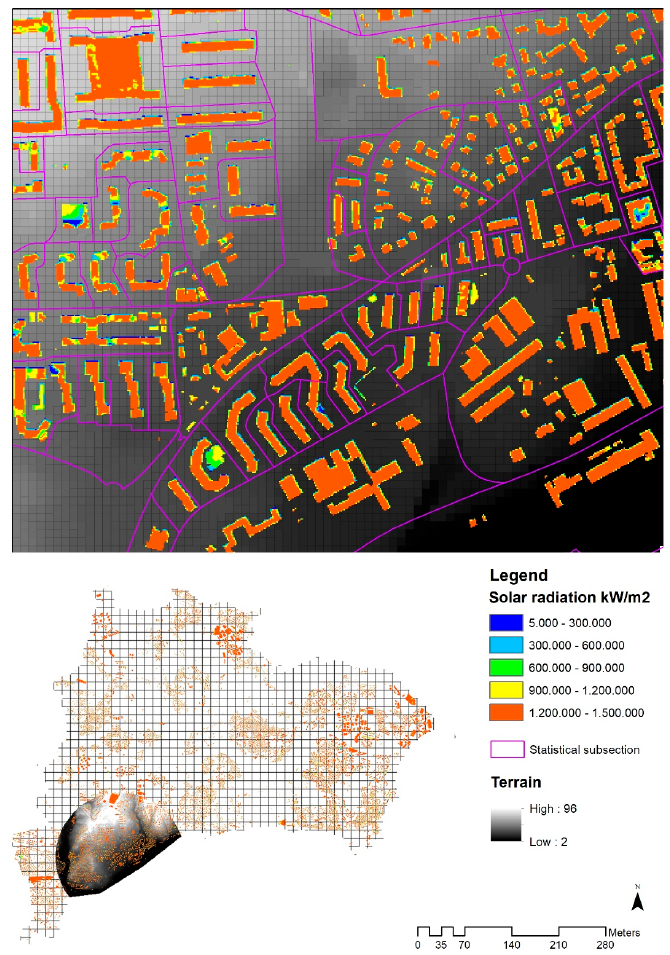
Figure 7. Extract of solar radiation estimation on building roofs (kWh/m 2 ). Energies 2018 , 11 , x FOR PEER REVIEW